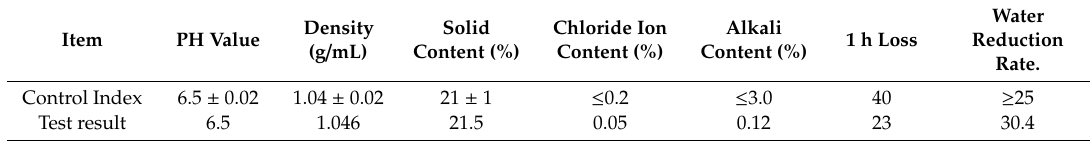
Table A3. Performance index of water reducer.